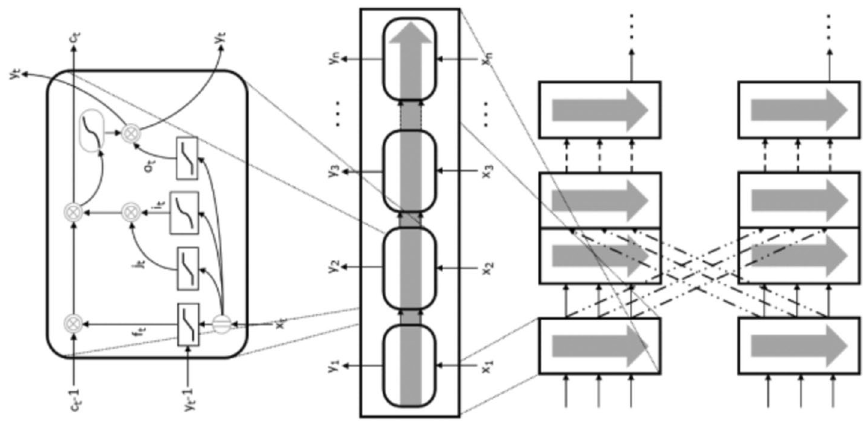
Fig. 20 Cross‑modal LSTM [111]